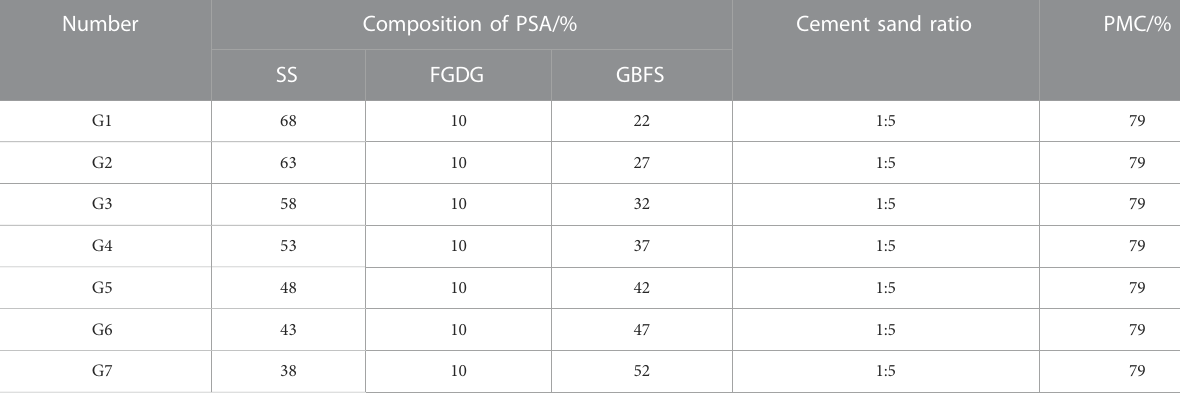
TABLE 2 Mix proportion of BFPBM.